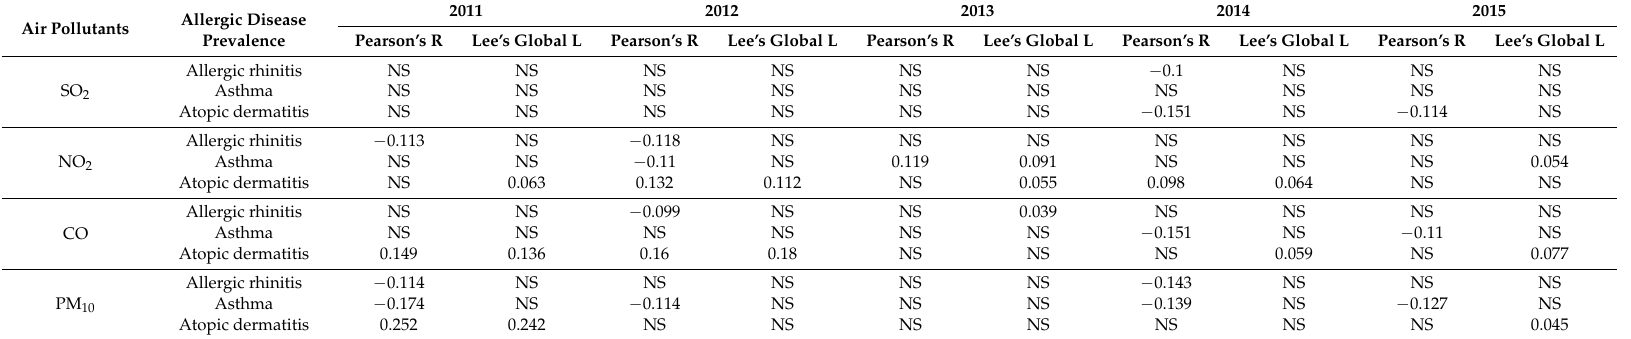
Table 2. Bivariate correlation between air pollutants and allergic disease prevalence: Pearson’s R vs. Lee’s